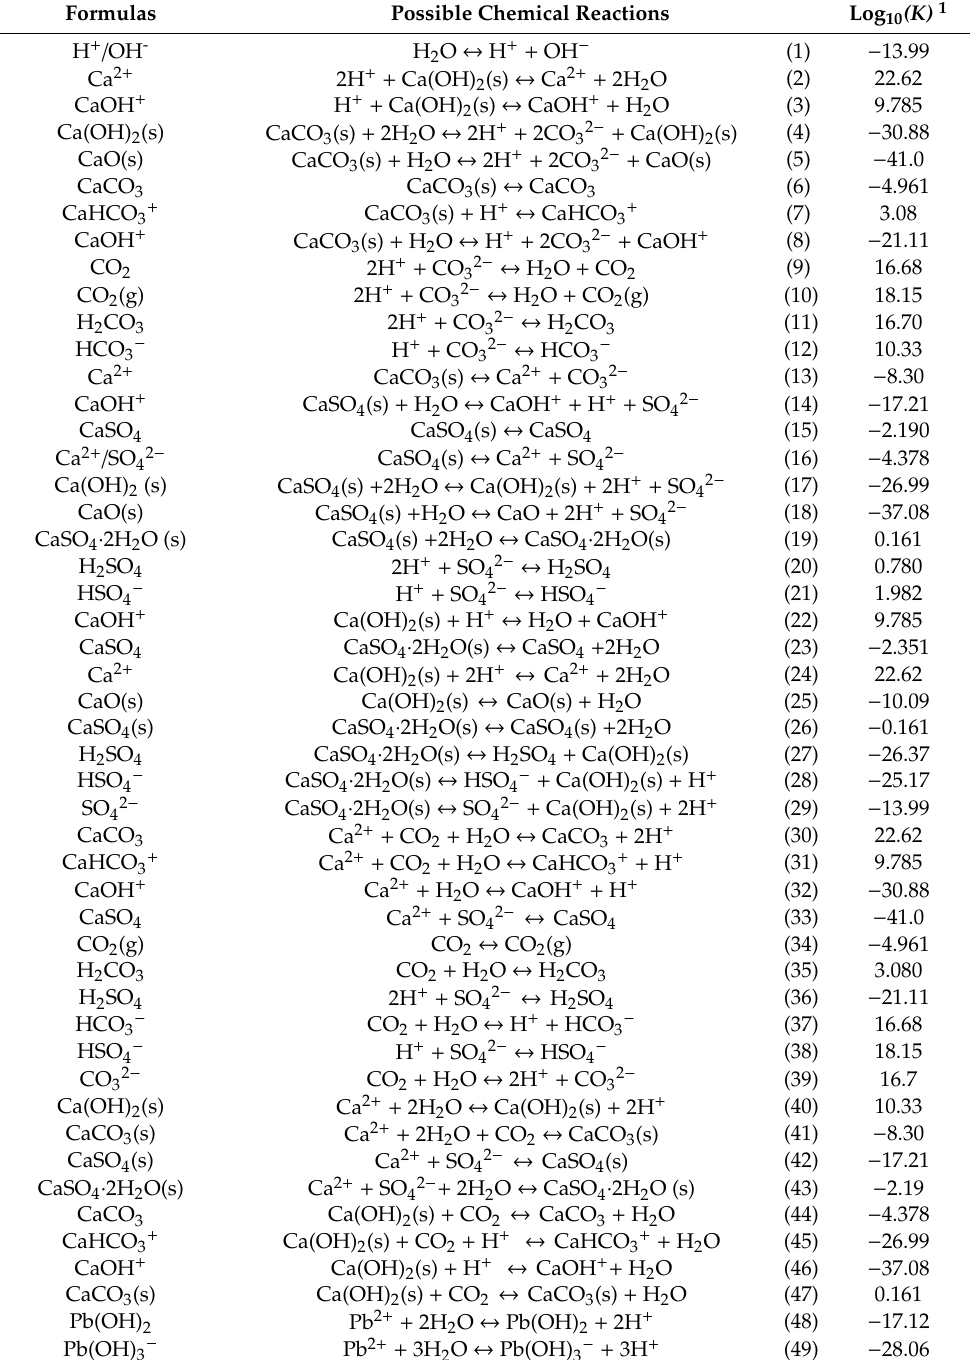
Chemicals, formulas, reactions, and equilibrium constants used in the thermodynamic